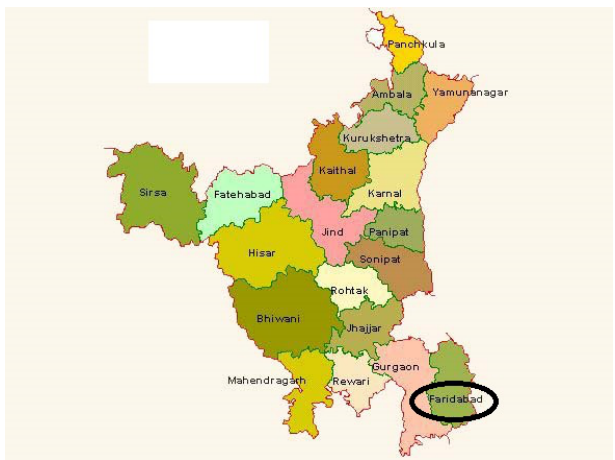
Figure 1. Map of the Study